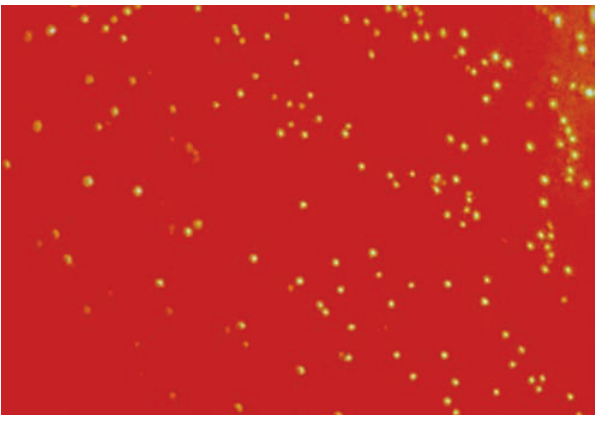
Figure 2. Minimum bactericidal concentration of S. persica extract on H. pylori isolated from stomch